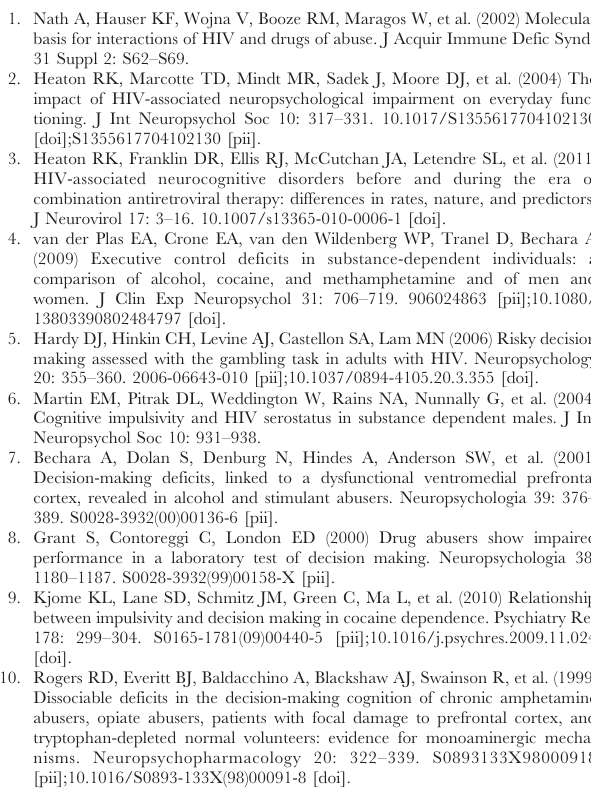
Figure S1 Parameter estimates of A (learning/memory) after controlling for age. Note: 300 random samples were drawn from the posterior distributions for each group. Dashed lines indicate mean values for each group. HDI= mean and 95% HDI range. (TIF) Figure S2 Parameter estimates of l (loss aversion) after controlling for age. Note: 300 random samples were drawn from the posterior distributions for each group. Dashed lines indicate mean values for each group. HDI= mean and 95% HDI range.